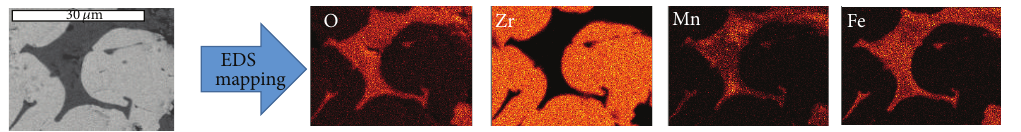
Figure 4: Solid state sample after calcination. SEM and EDS mapping at 3,000x magnification (the length of the scale bar in the SEM image is 30 𝜇 m).